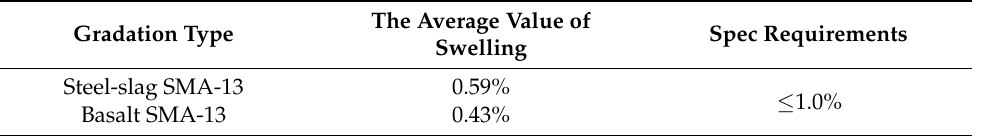
Table 7. Expansion test of asphalt mixture.